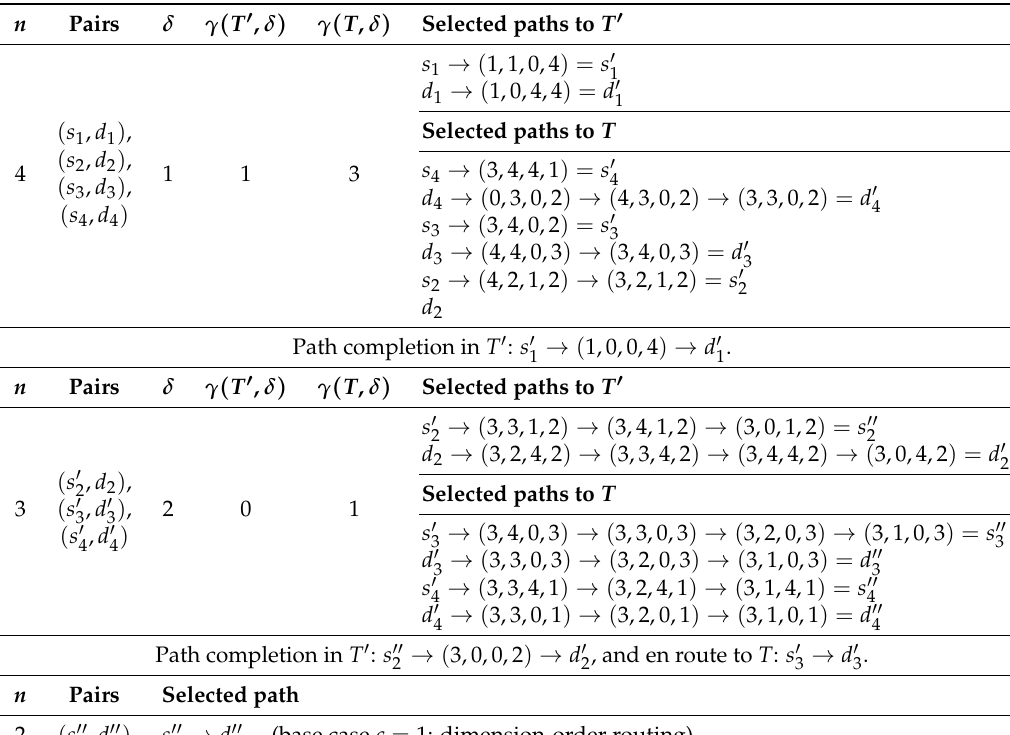
Table 2. A possible algorithm execution trace in a (4, 5)-torus and the four vertex pairs { ( s 1 , d 1 )